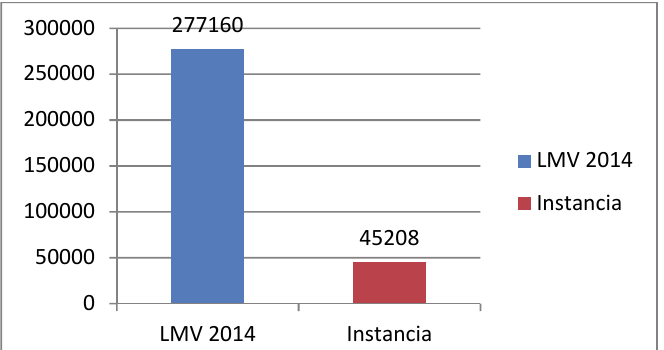
Fig. 2. Comparison of the number of km traveled by referees in group A of the 2014 World Volleyball League (2014 WVL) to the result given by the model (Instance) Source: The